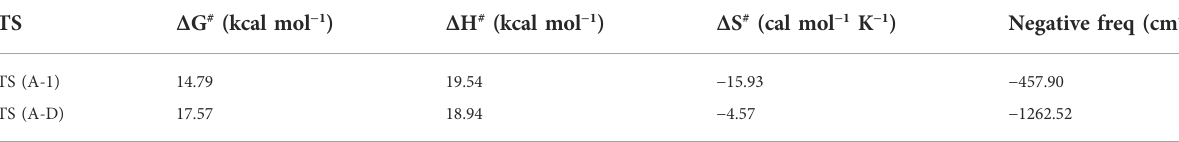
TABLE 1 Thermodynamic parameters as well as the negative frequency values of TSs for the possible reaction